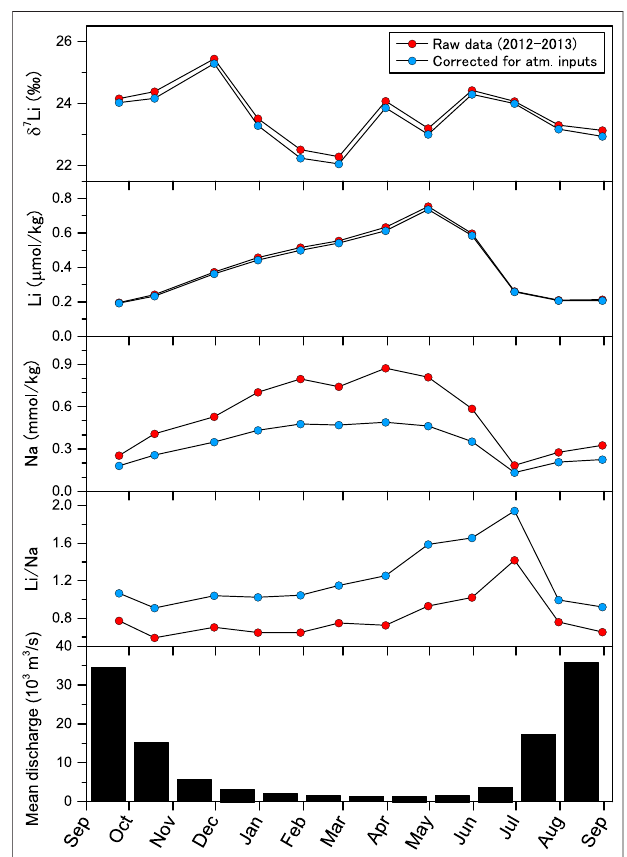
FIGURE 2 | Annual variation in δ 7 Li, Li concentration, Na concentration, and the Li/Na ratio ( μ mol kg − 1 /mmol kg − 1 ) of the Ganges River at the Harding Bridge, Pakshi ( Figure 1 ) from October 2012 to August 2013. Concentration and isotopic data were corrected for atmospheric salt inputs using Li/Cl ratios. The bottom panel represents the Ganges River ’ s mean monthly discharge at the Harding Bridge (Mirza, 1998).